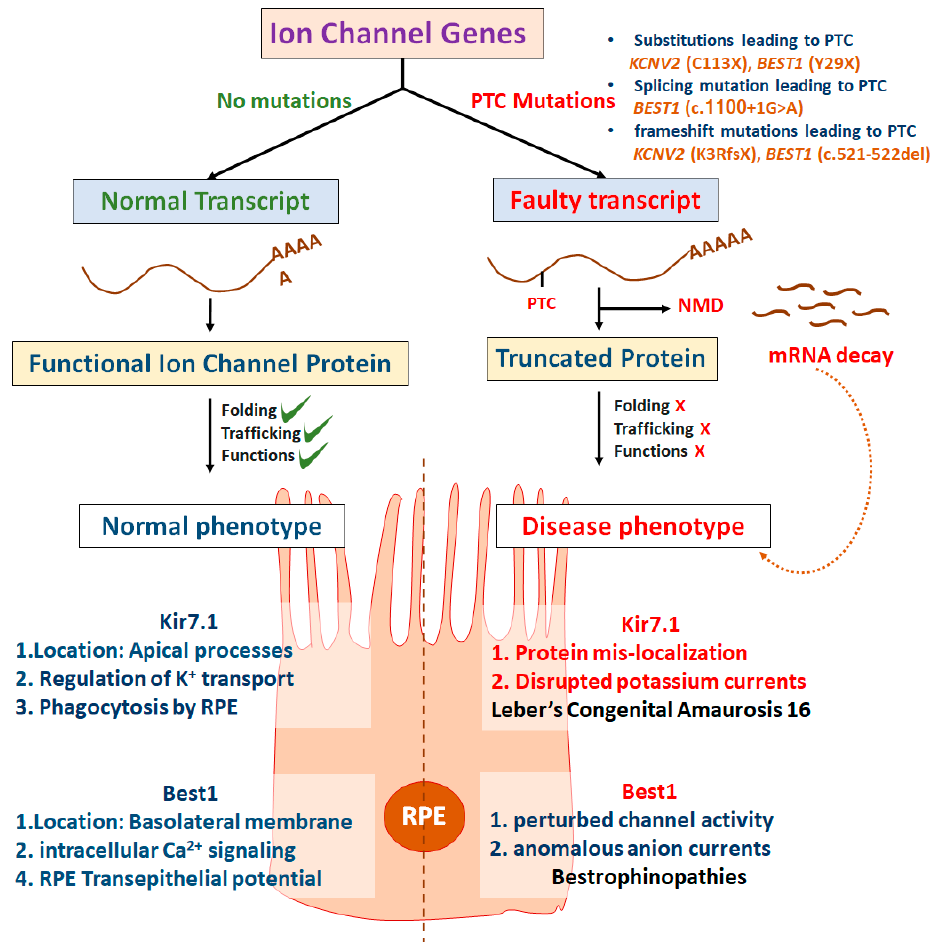
Figure 4. Leading nonsense mutation channel dysfunctions in the retinal pigmented epithelial (RPE) layer, causing genetic blindness. Table 1. Nonsense mutations in the eye and resulting channelopathies.